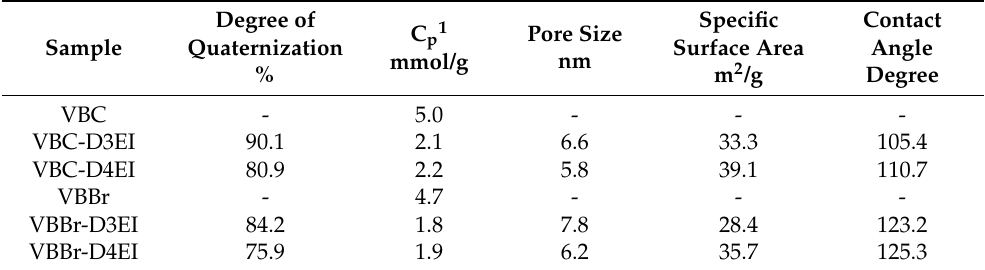
Table 2. Results of elemental, textural, and wettability analysis of the fabricated